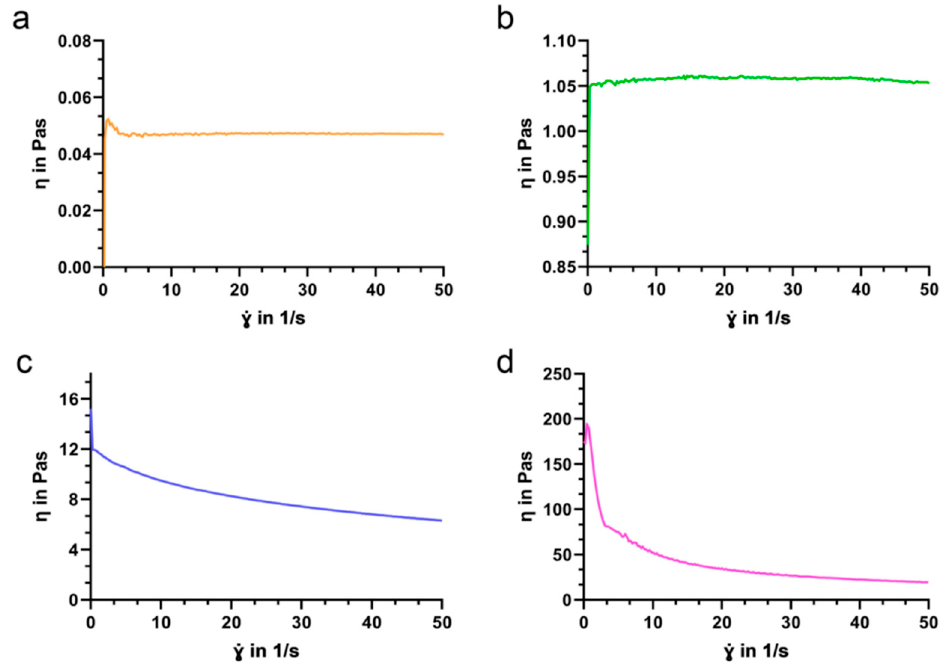
Figure 2. Rheological properties of chitosan solutions with different concentrations. ( a – d ) Viscosity– shear rate curve of chitosan solution with different concentrations. ( a ) 1%, ( b ) 3%, ( c ) 5%, ( d ) 7%.